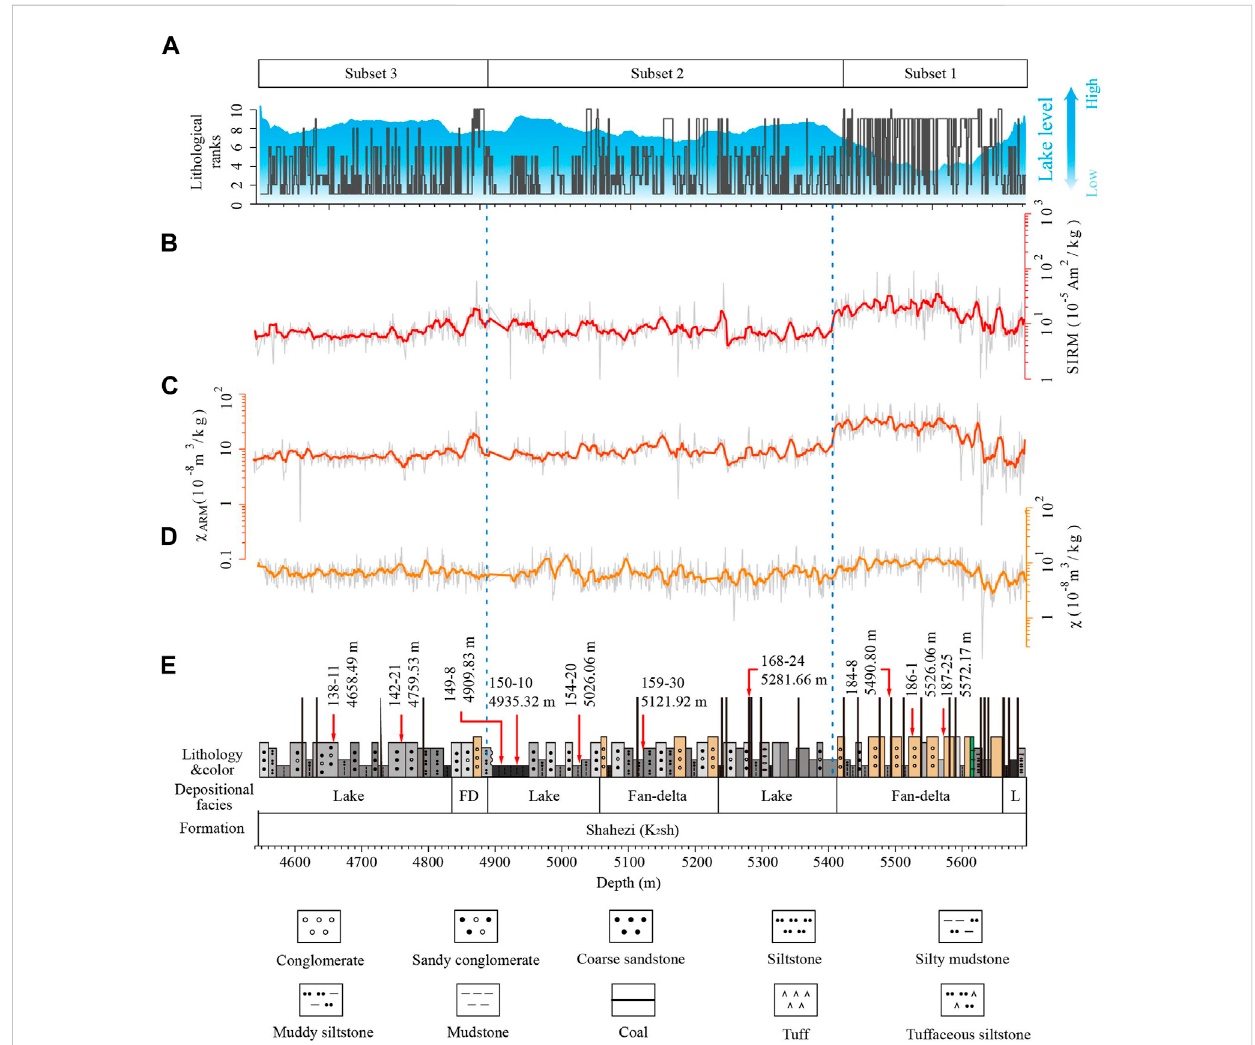
FIGURE 3 Magnetic parameter pro fi les for sediments of the lower K 1 sh (4,542 – 5,694 m) from the SK-2 borehole (A) Lake level fl uctuations (the blue shading) aremodeledfromthevariationsoflithologicalranks (B) SIRM (C) χ ARM (D) χ (E) Stratigraphy,depositionalfaciesandlithologyofthestudiedstrata,withred arrowheads pointing to the corresponding depths of the selected representative samples for rock magnetic experiments. FD: Fan-delta. L: Lake. Depositional facies are modi fi ed from Liu et al. (2020). Dashed blue lines divide the succession into Subset 1, Subset 2, and Subset